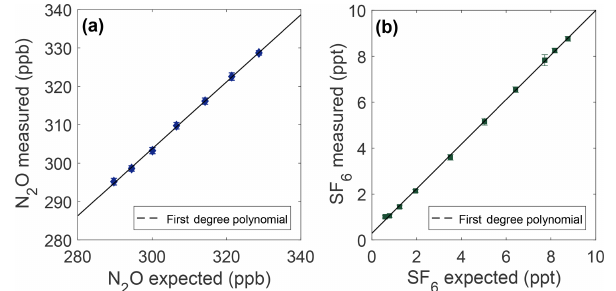
Figure 4. Measurement linearity from plots of the measured mole fraction vs. the expected mole fraction of N 2 O (a) and SF 6 (b) . The expected mole fraction is calculated from the NOAA reference mole fraction (328.71ppb N 2 O and 8.76ppt SF 6 ) after dilution with ultrapure air. Error bars represent 1 σ total